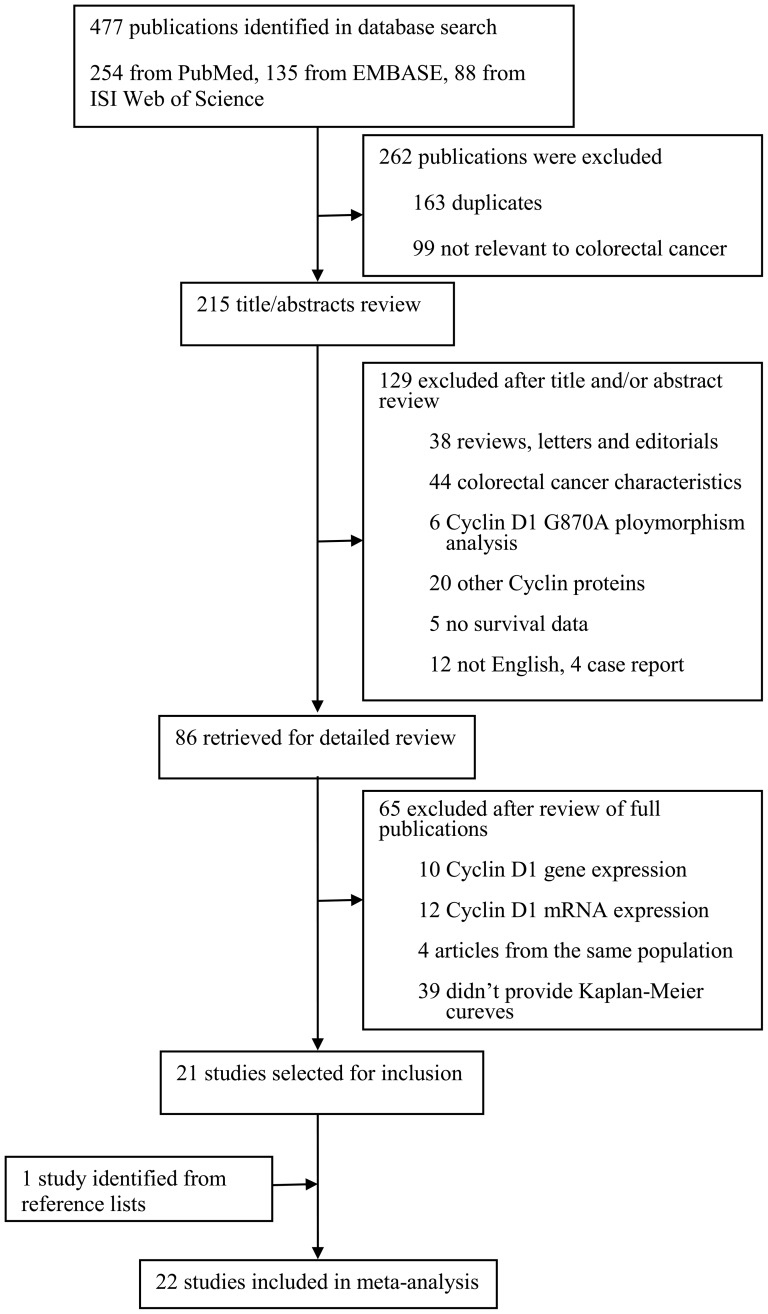
Flow diagram of screened, excluded, and analyzed publications.